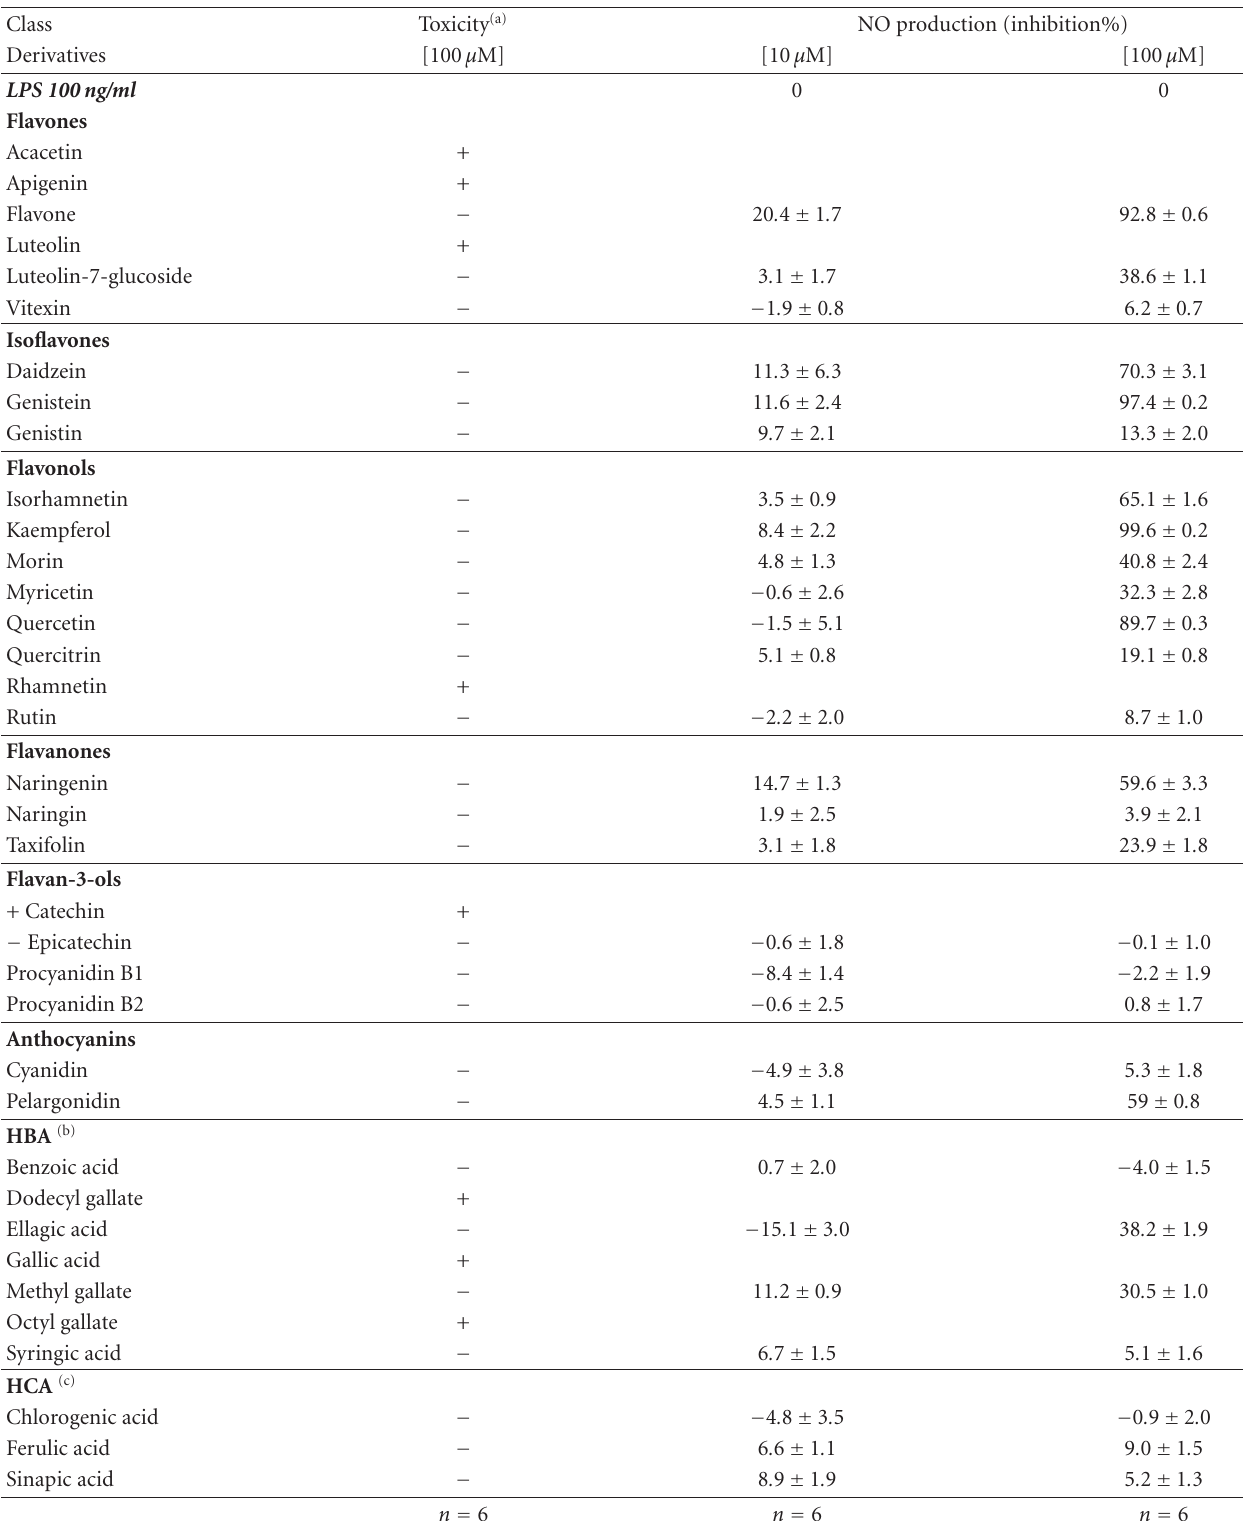
Table 2: E ff ects of phenolic compounds on cell viability and on LPS-induced (100ng/ml) NO production in J774 macrophages. No de- tectable NO production was found in untreated cells. Mean ± standard error of mean